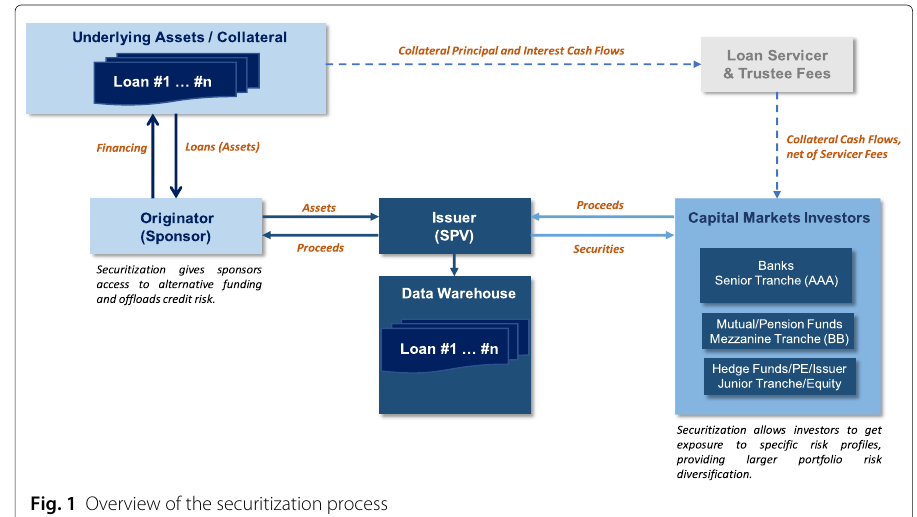
Fig. 1 Overview of the securitization